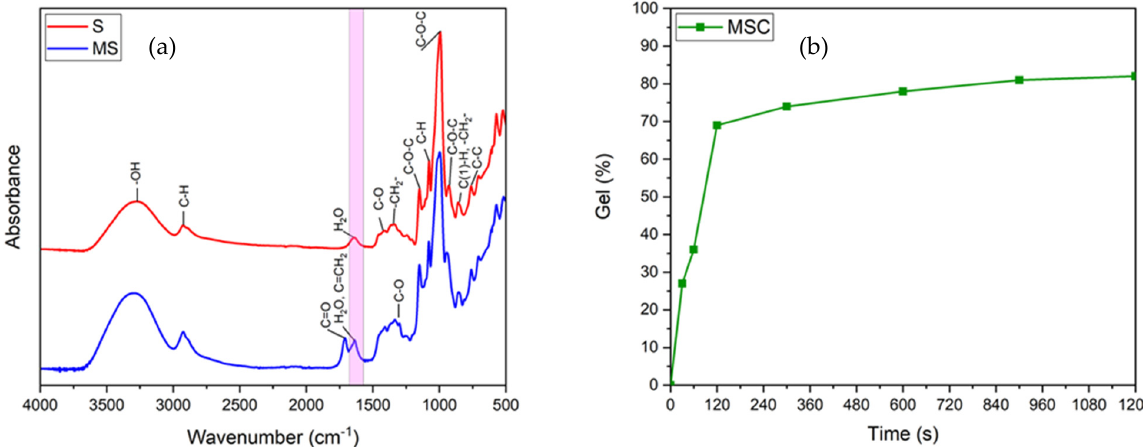
Figure 1. ( a ) FTIR spectra of Starch (S) and methacrylated starch (MS); ( b ) Evaluation of gel content after different UV-curing times for MSC films.